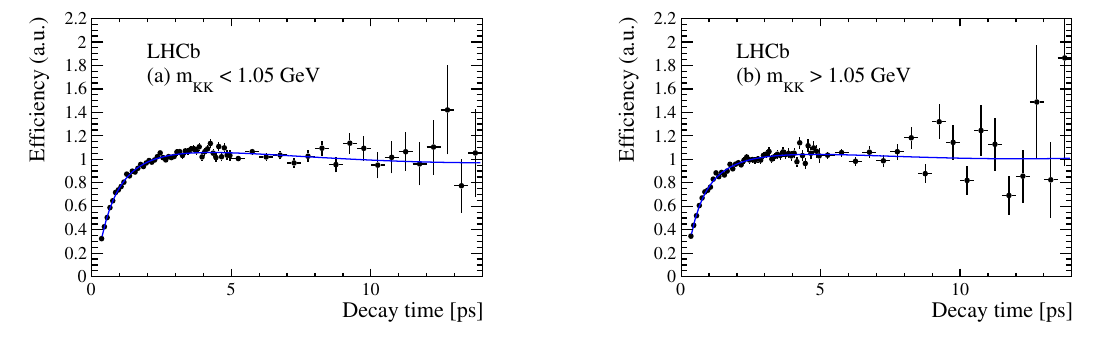
0 ( t ) in arbitrary units (a.u.) for (a) the (cid:30) (1020) region s data